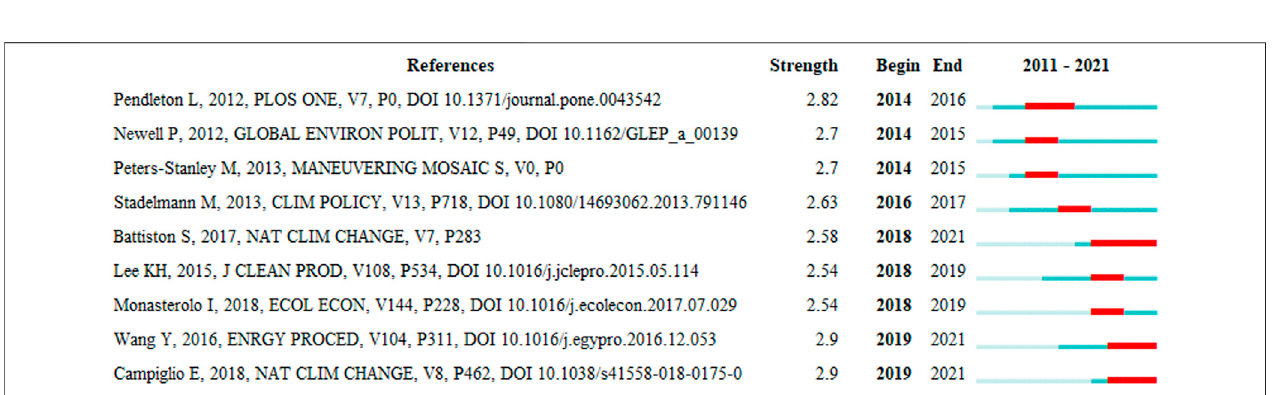
FIGURE 12 | High burstiness of references. The green line represents the period during which the reference appeared, and the red line indicates the period during which the reference received wide attention.